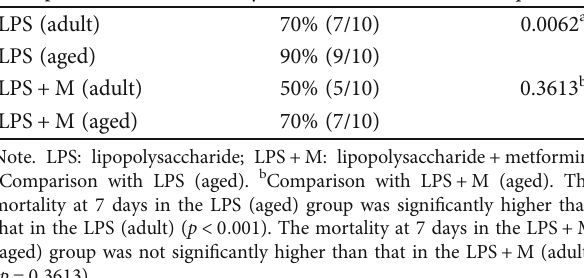
Figure 1: (a) Mouse model diagram. (b) MSS score and neurobehavioral score of dentate gyrus of adult mouse brain tissue. (c) MSS score and neurobehavioral score of dentate gyrus of aged mice brain tissue. (d) Survival curves of adult and aged mice. The mice were intraperitoneally injected with LPS, then, given metformin 1 hour later. The vital signs of the mice were observed for the following 7 days, and MSS score and neurobehavioral score were given every day. When THE MSS score reached 21, the death was determined, and the brain tissue was dissected for use. In the legend of the survival curve, the mortality rate of the aged mice after LPS administration was signi fi cantly higher than that of the adult group, while the e ff ect of metformin treatment in the aged group was signi fi cantly lower than that in the adult group. LPS: lipopolysaccharide. Table 2: Mortality of aged groups and adult groups among groups.